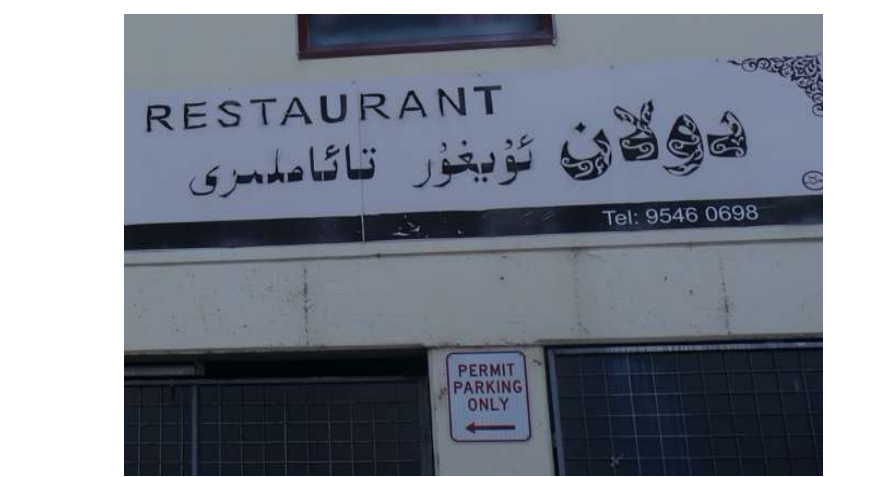
Figure 4. Other minority